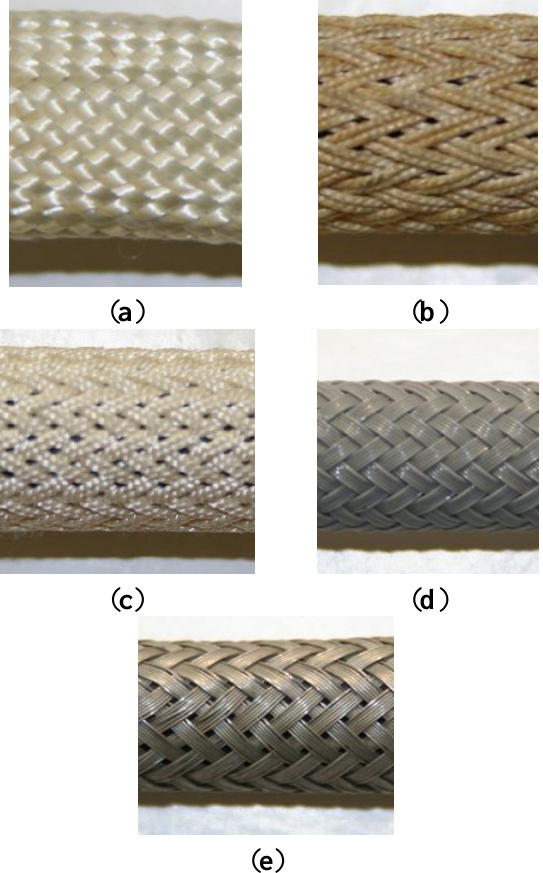
Figure 2. Various braided sleeves of the pneumatic McKibben artificial muscle, ( a ) Historical McKibben muscle made of thin cotton yarns; ( b ) Bridgestone‘s ―rubbertuator‖ made of rayon yarns and ( c ) actual similar McKibben artificial muscle used by the authors; ( d ) Prototype made of braided thin plastic wires; ( e ) Prototype made of braided thin metal